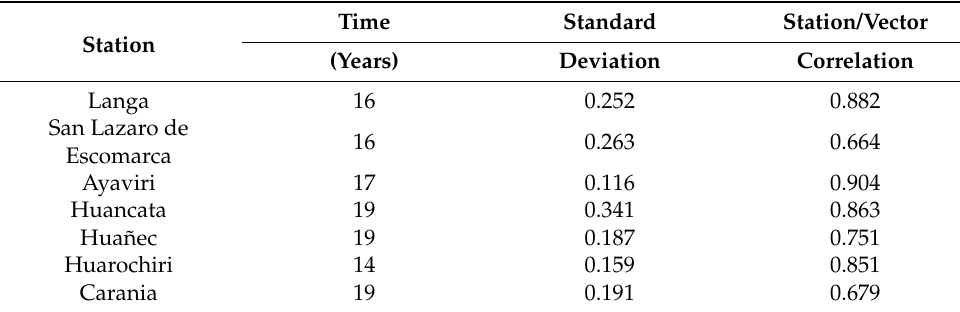
Figure 8. Optimal number of clusters according to the elbow method. Table 3. Annual regional vector indices—Region 1.